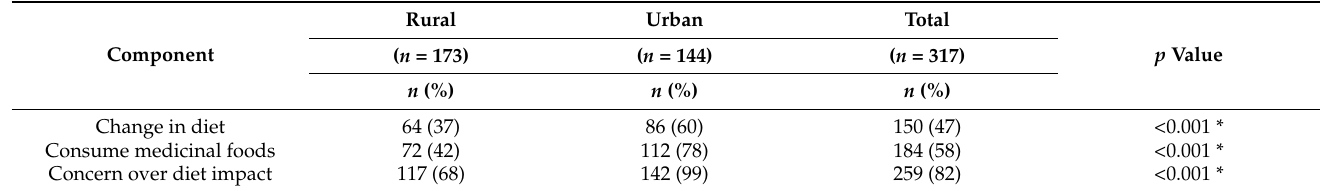
Table 4. Perceived impact of COVID-19 pandemic on household diet in rural and urban